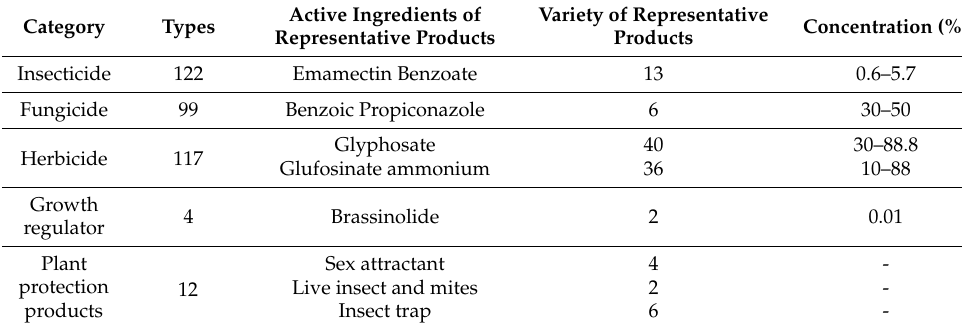
Table 1. Pesticides and representative products offered by CPD in X County in